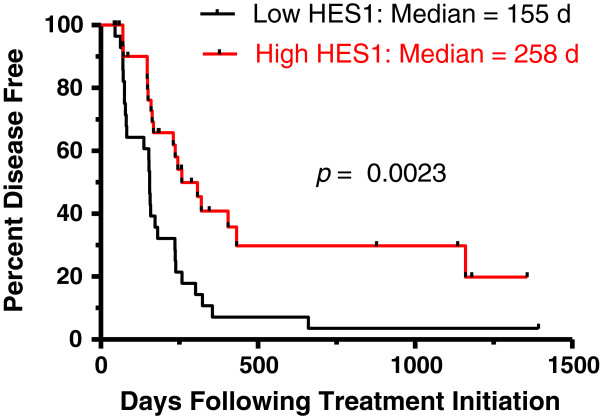
High HES1 immunoreactivity score correlates with lower histologic grade and improved outcome in canine osteosarcoma. Kaplan-Meier plot of disease free interval based on HES1 immunoreactivity score. Dogs with high HES1 scoring tumors (score ≥ 4, n = 28) had a statistically significantly longer disease free interval than dogs with low HES1 scoring tumors (score < 4, n = 33) (p = 0.0023, Log Rank test).